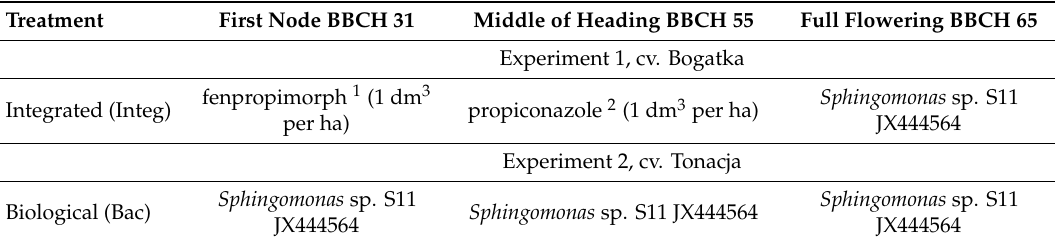
Table 1. Treatments applied to winter